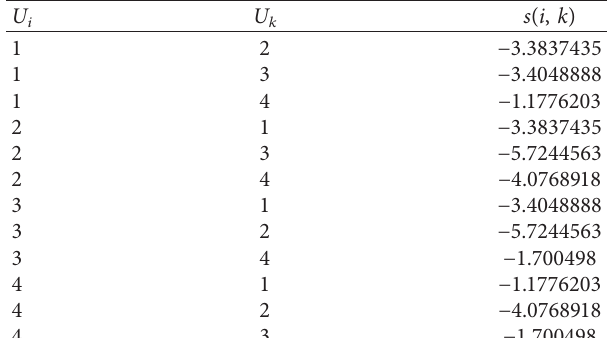
Table 3: A sample similarity